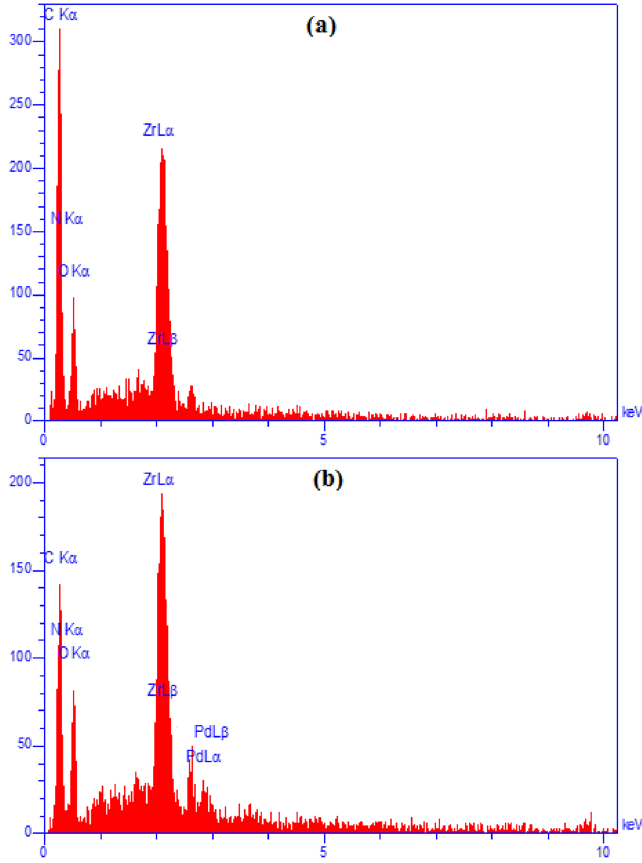
Figure 4. EDX spectra of UiO-66-NH 2 ( a ); and UiO-66-biguanidine/Pd nanocomposite ( b